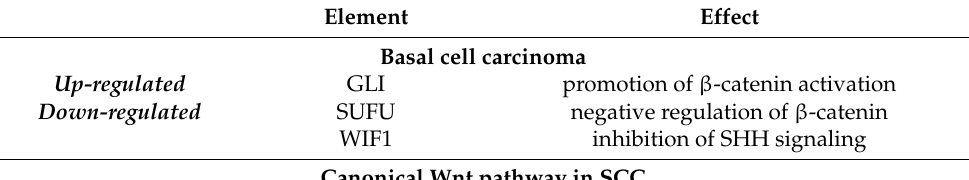
Table 1. Canonical and non-canonical Wnt signaling elements involved in pathogenesis of NMSCs. Element Effect Basal cell